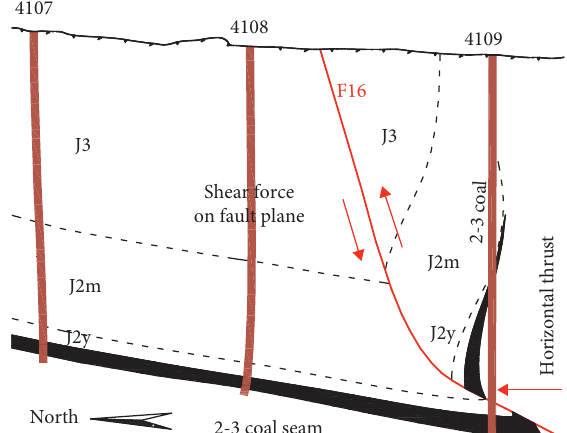
Figure 3: The morphology of faultF16 in A-A’ section